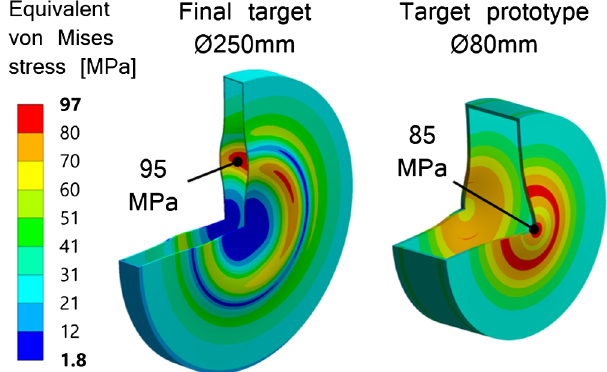
FIG. 8. Von Mises equivalent stress distribution in the Ta2.5W cladding of the most loaded target block (block 4) after beam impact. Comparison between the final target (left) and the target prototype at 3 × 10 12 ppp (right). The different stress distribution due to the beam dilution or nondilution is noticeable.